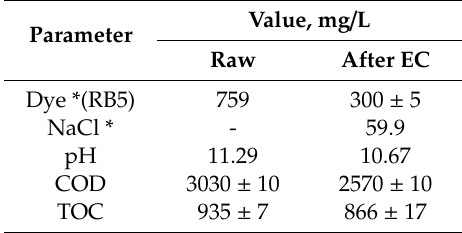
Table 1. Parameters of raw and pretreated wastewater.